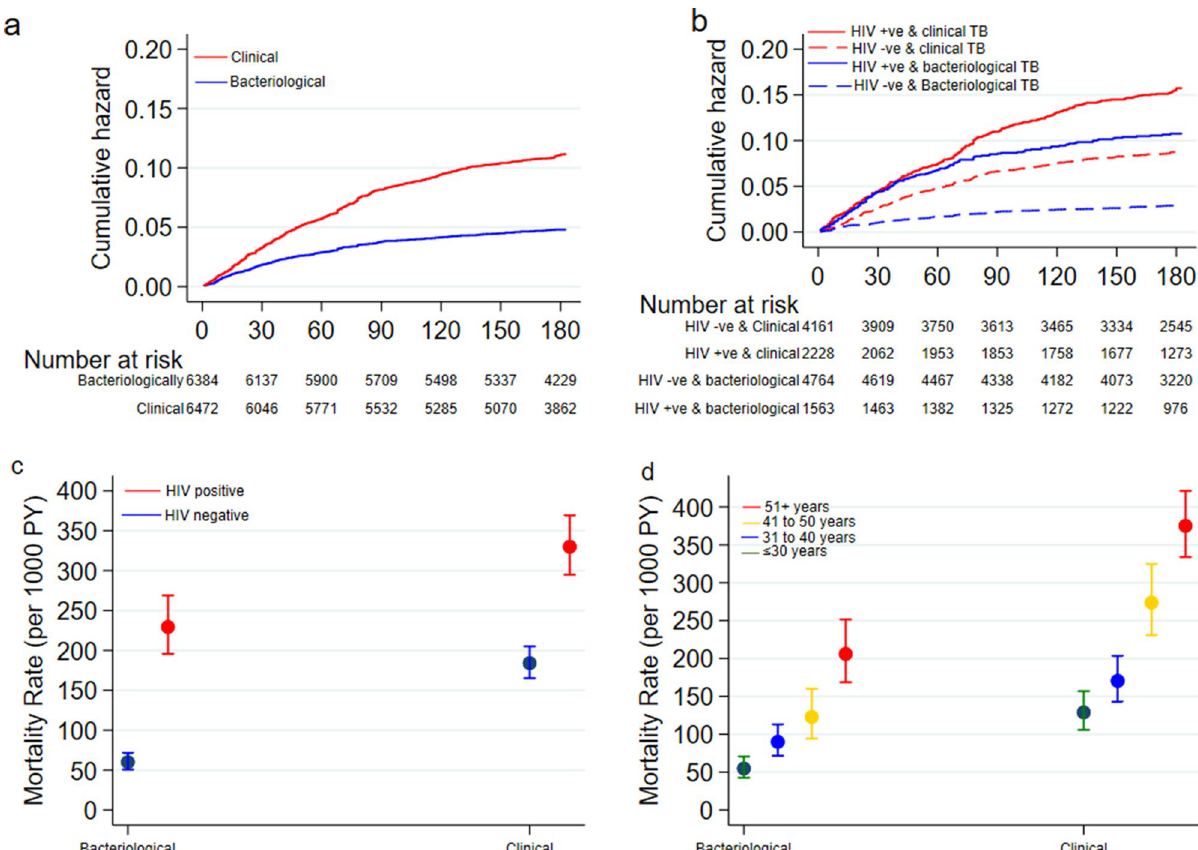
Figure 1. (A) Cumulative hazard of deaths stratified by type of TB diagnosis; (B) cumulative hazard of deaths stratified by type of TB diagnosis with HIV status; (C) mortality rate stratified by type of TB diagnosis with HIV status and (D) mortality rate stratified by type of TB diagnosis with age groups.